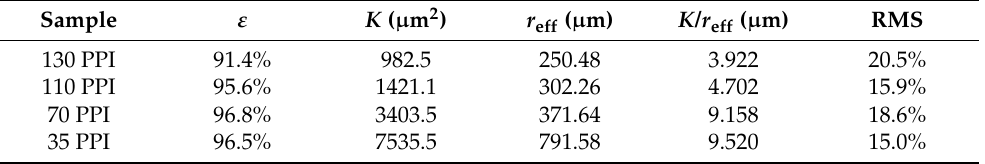
Table 3. Capillary performance parameters in copper foams with different PPI.